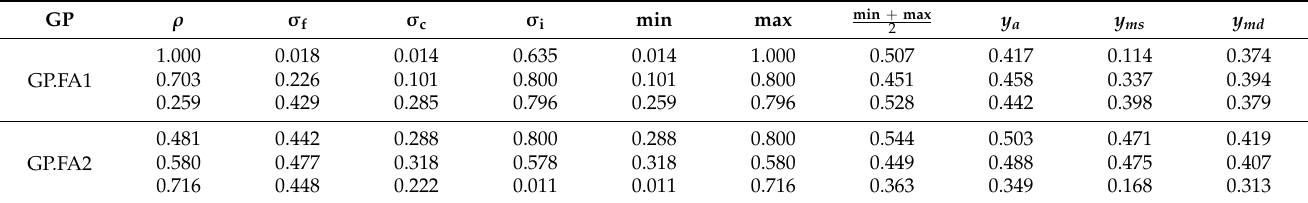
Table 7. Matrix of dimensionless values of parameters of geopolymers, as well as values of convolu- tions and